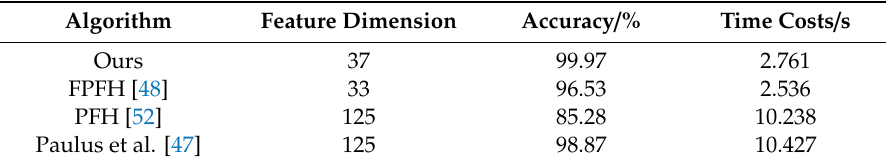
Table 3. Results of segmentation accuracy and processing time costs of different surface feature histogram algorithms.